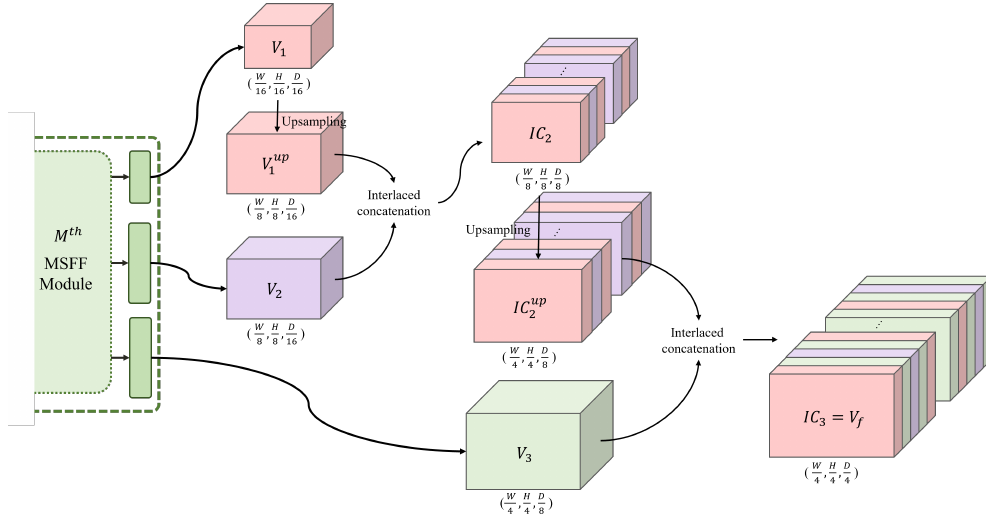
Figure 7. Process of interlaced